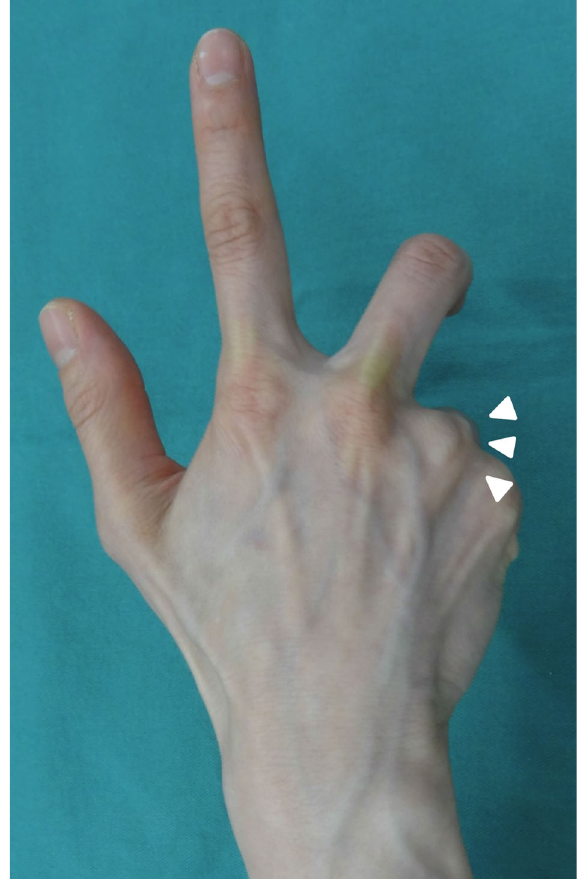
Figure 1: (a) Shiatsu-speci fi c hand posture. (b) When the metacarpophalangeal joint (MCPj) of the ring fi nger is fl exed and deviated ulnarly with concurrent extension of the MCPj of the middle fi nger, the extensor tendon of the ring fi nger dislocates ulnarly (white